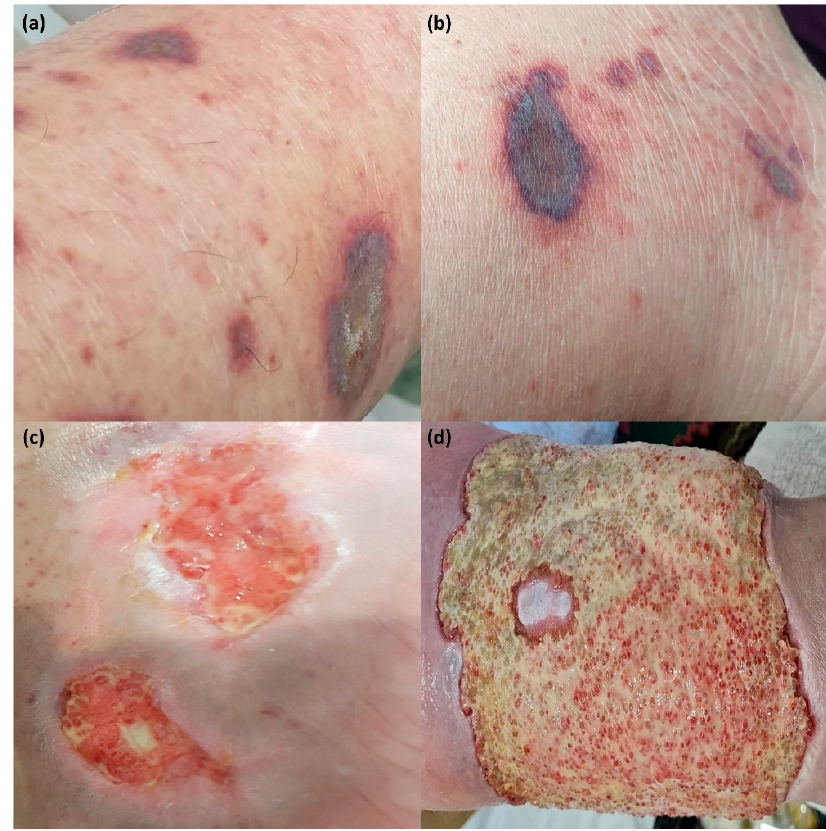
Figure 1. Distal lower limbs palpable purpura in a woman suffering from primary Sjögren’s Syn- drome associated with leuko-cytoclastic vasculitis ( a , b ). In evolution, severe vasculitis manifestation and wide skin ulcer ( c , d ). wide skin ulcer ( c , d